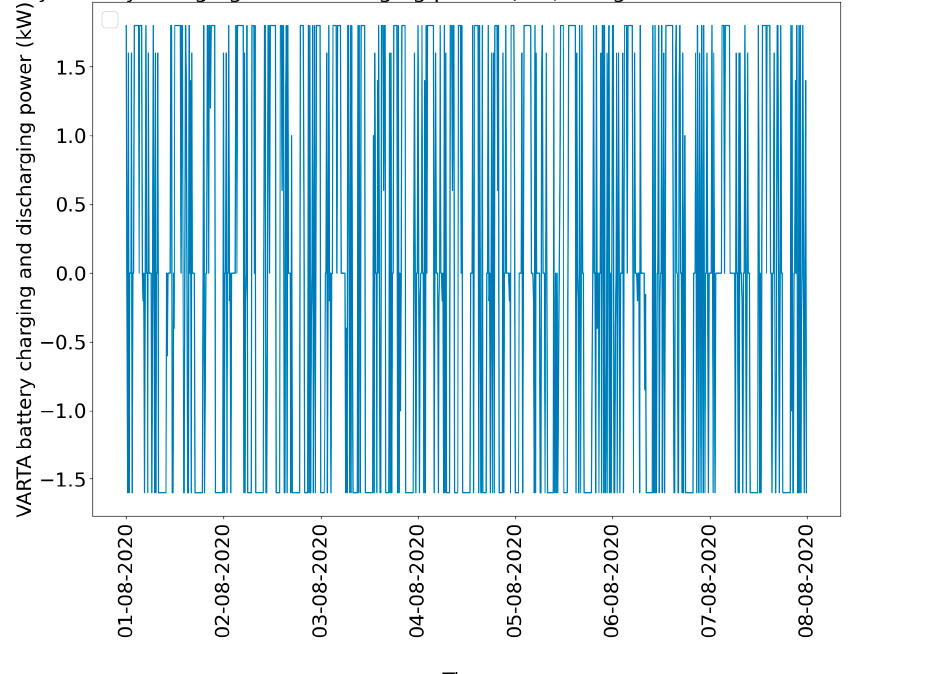
Figure A7. VARTA battery charging and discharging curve—January—Method 2.